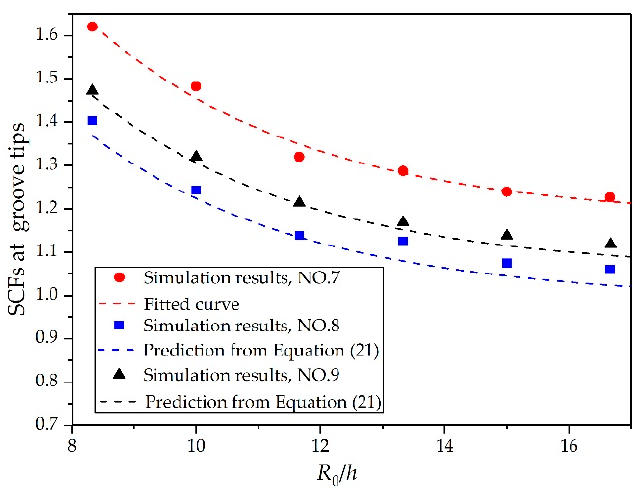
Figure 13. Relationship between R 0 / h and SCFs at groove tips.